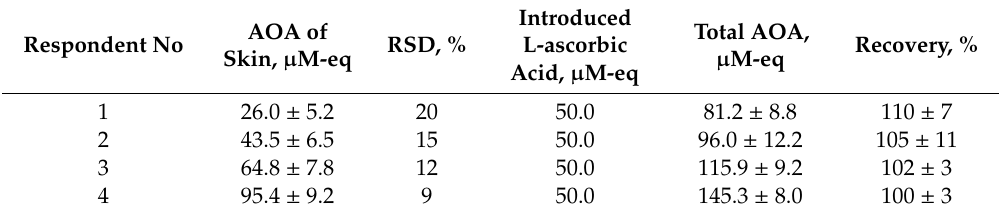
Table 3. AOA of skin and L-ascorbic acid recovery (n = 2, α =